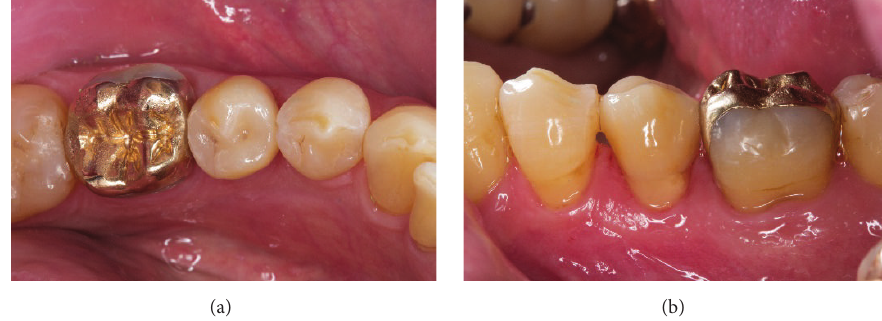
Figure 13: Clinical situation two days after adhesive